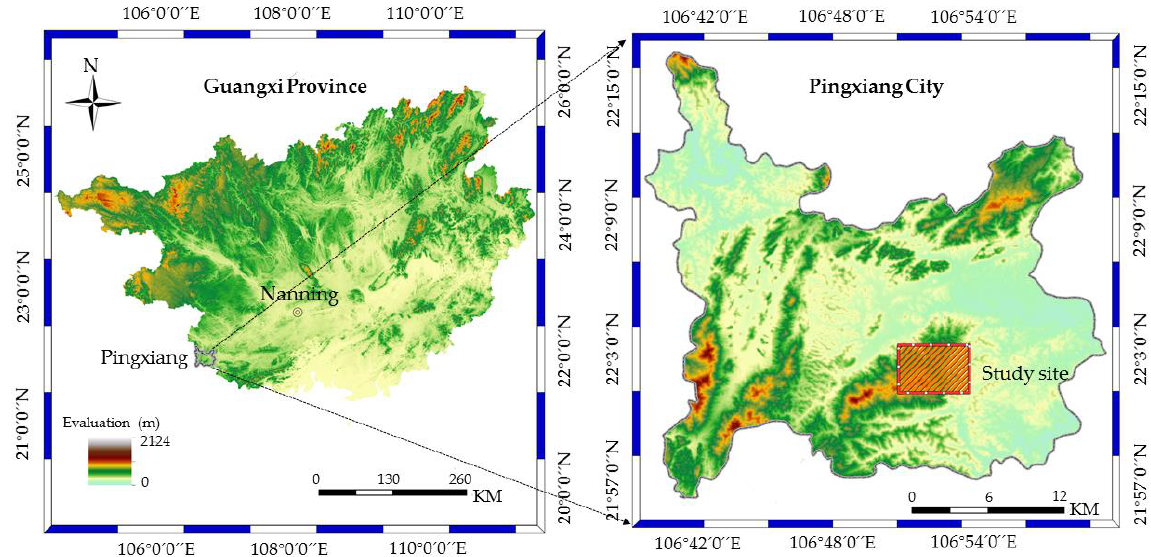
Figure 1. The sampling plot is located on the southwest side of the subtropical monsoon climate region, Guangxi Province, China.